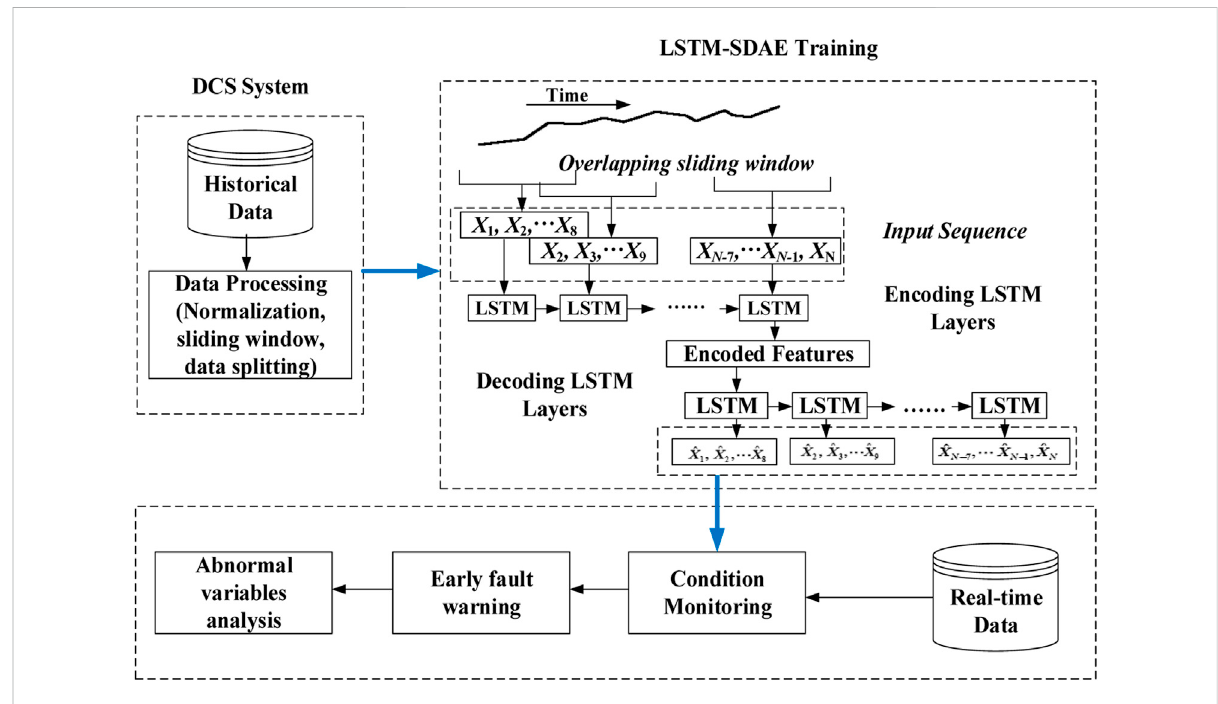
FIGURE 4 The LSTM-SDAE framework of condition monitoring and early fault